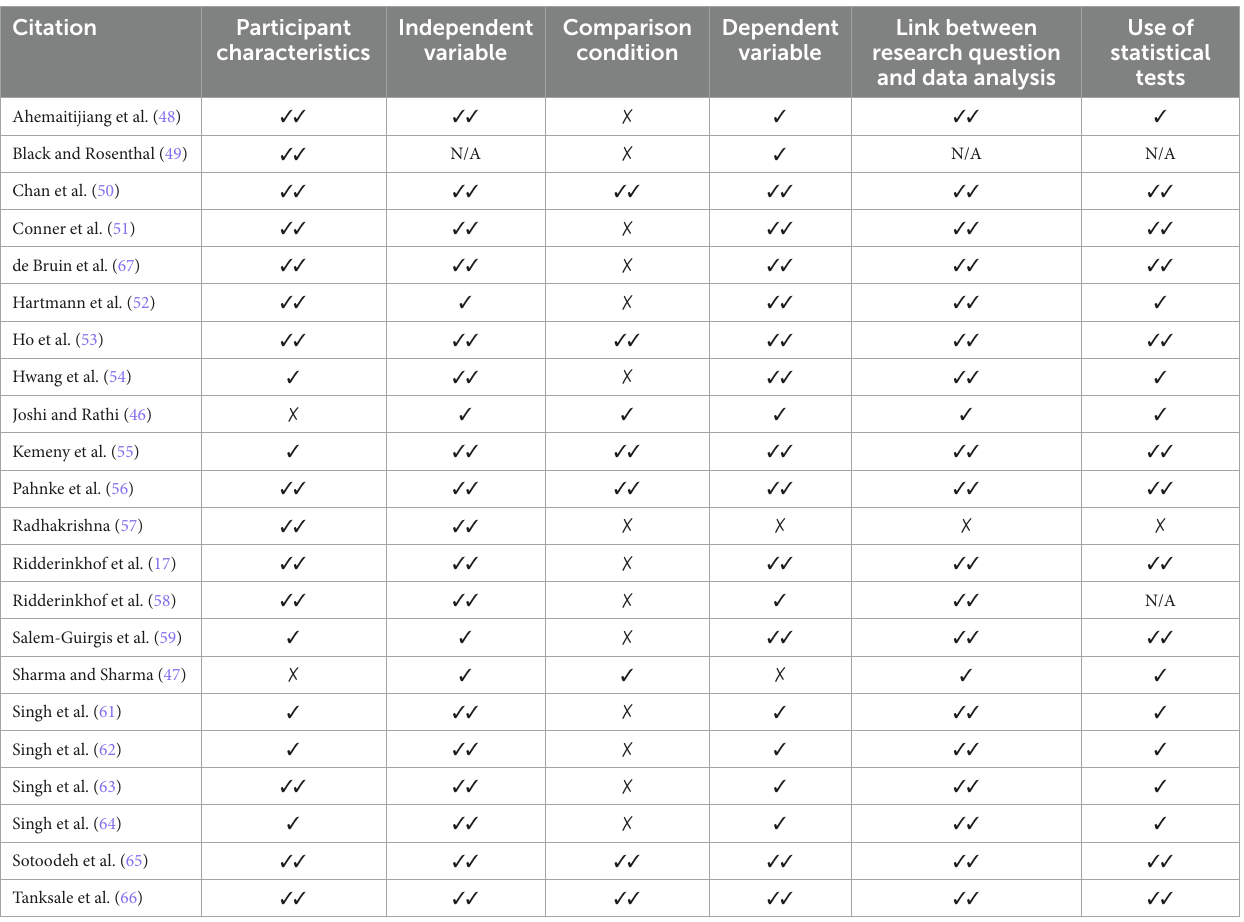
TABLE 2 Primary quality indicators of group research.